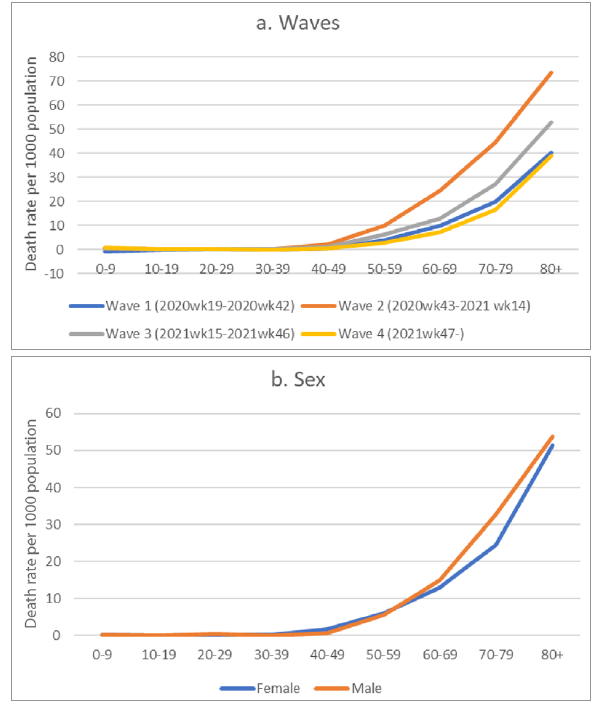
Figure 5: Age-specific annualised excess death rates (per 1000 population) by (a) wave and (b) sex in South Africa. (Excess deaths from 3 May 2020 – 29 January